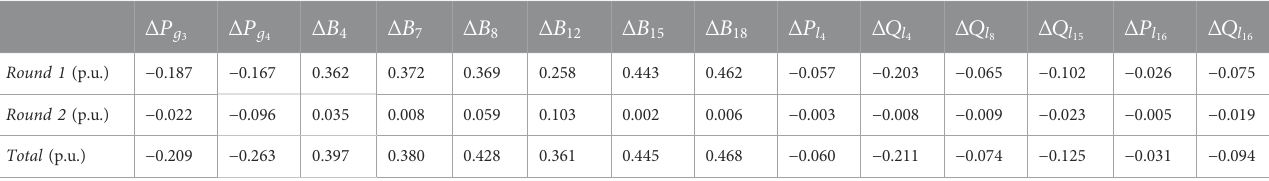
TABLE 3 The minimum quantity of control